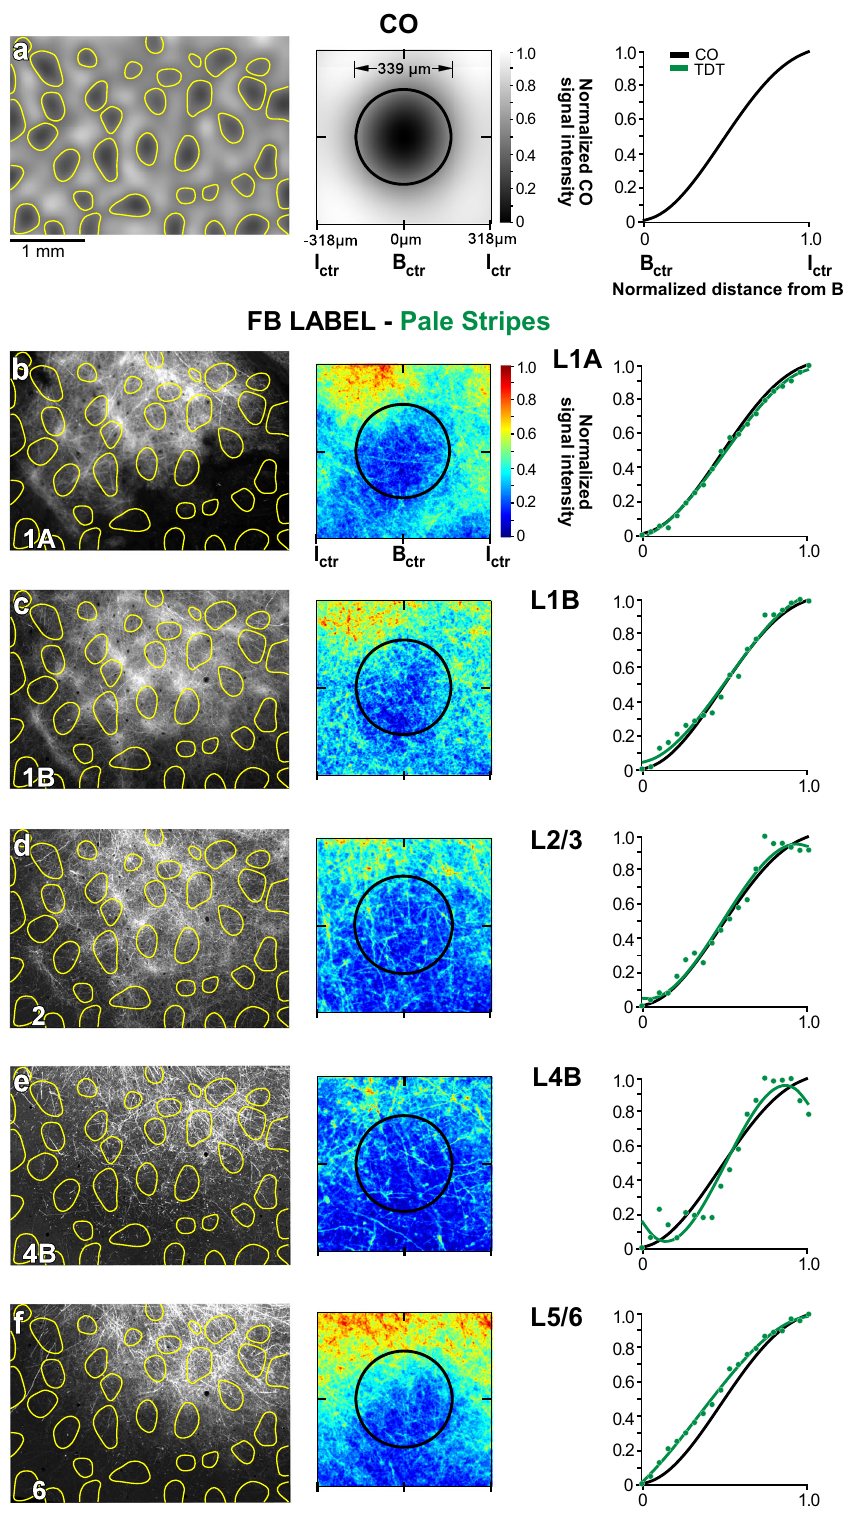
Fig. 6 V2 pale stripes project to V1 interblobs. Case MK374RHLat. Same as in Fig. 4, but for tdT-labeled FB axons in V1 resulting from the AAV9-tdT injection site con fi ned to a pale-medial stripe shown in Fig. 2a – c. In all layers, GFP-label intensity dominates in the interblobs. Results in ( a – f ) are representative of three independent injections centered in pale stripes. Source data for right panels in ( a – f ) are provided as a Source data fi